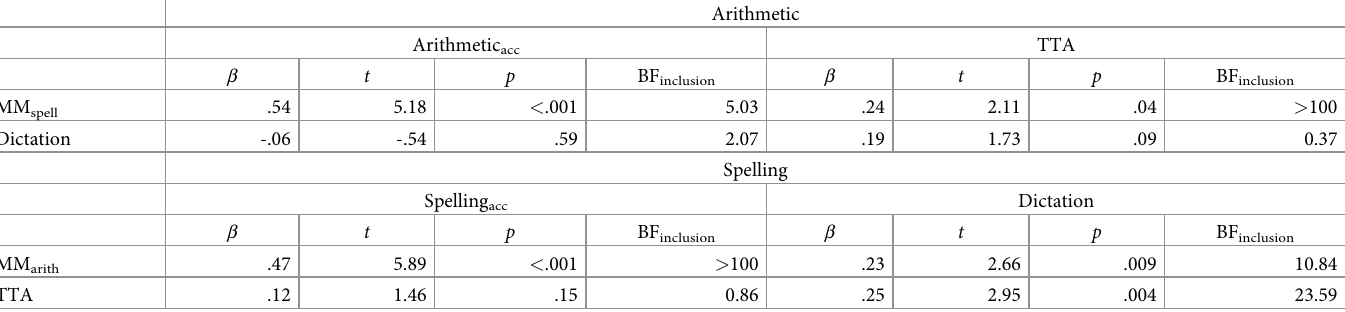
Table 3. Regression analyses of arithmetic performance (i.e., arithmetic acc and TTA) and spelling performance (i.e., spelling acc and dictation) with metacognitive monitoring in the other domain and standardized task performance in the other domain as